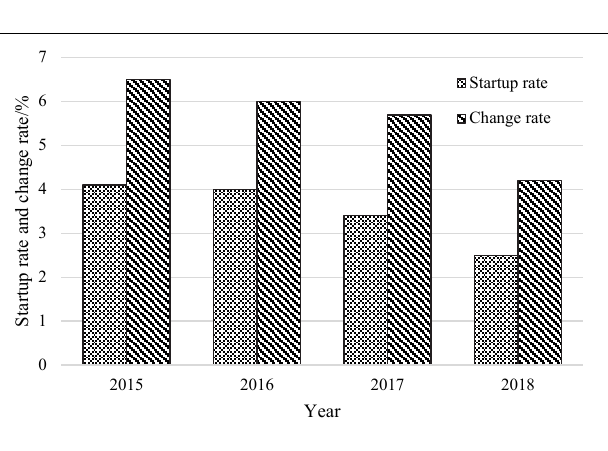
FIGURE 6 | The retrial initiation rate and judgment alteration rate of the intermediate people’s court of Guangdong